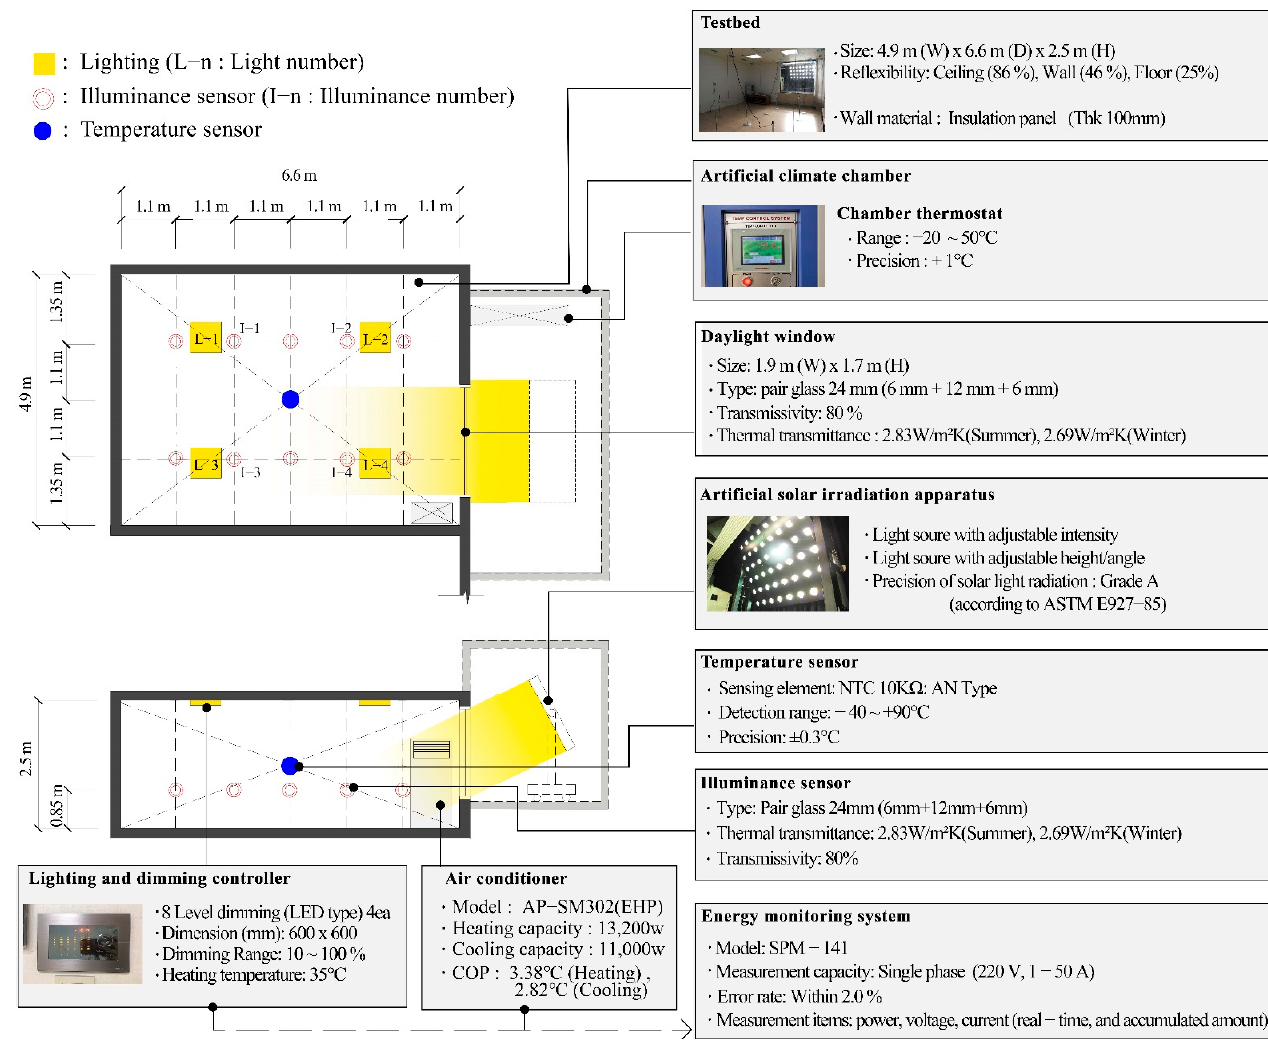
Figure 4. Overview of the test bed.